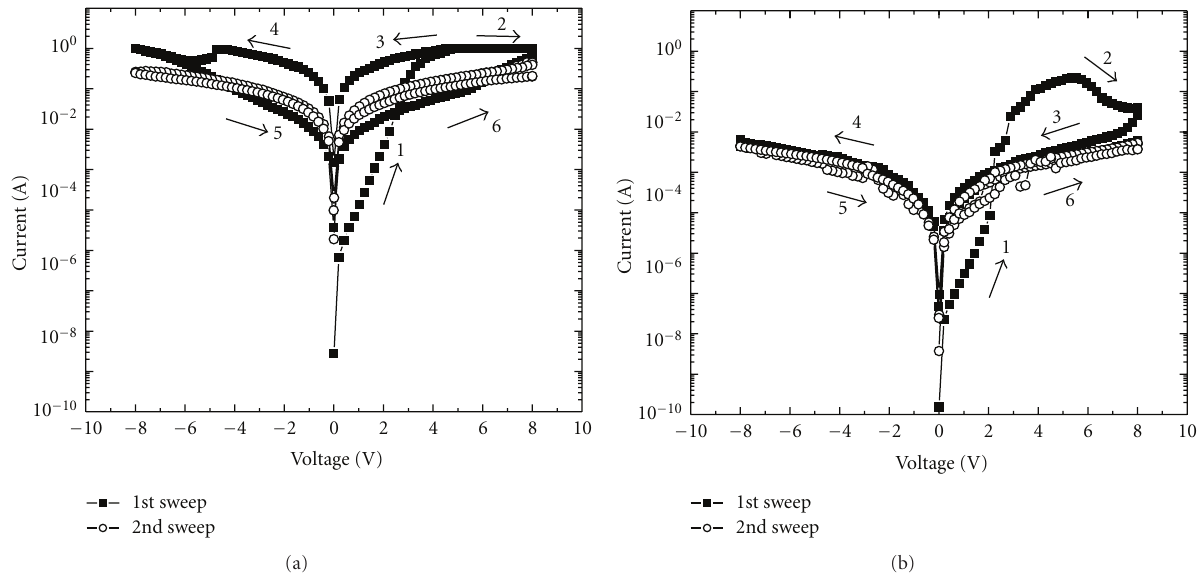
Figure 4: I-V response of Al/PS/Al devices. PS was dissolved with CB, for two di ff erent PS thicknesses: (a) 11nm and (b) 18 nm. Note that the results are basically similar to those of PMMA devices in a similar thickness